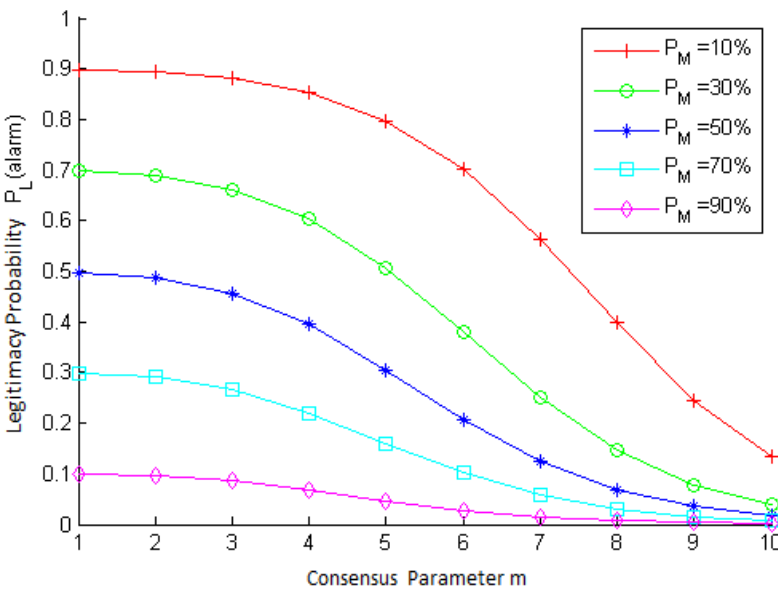
Figure 6. Legitimacy probability of a node when the intrusion detection system (IDS) ( alarm ) , vs. the consensus parameter m , for different values of generates a global alarm, P L P = 0 . 6 and P = 0 . 4 , N = 10 , P M tp fp